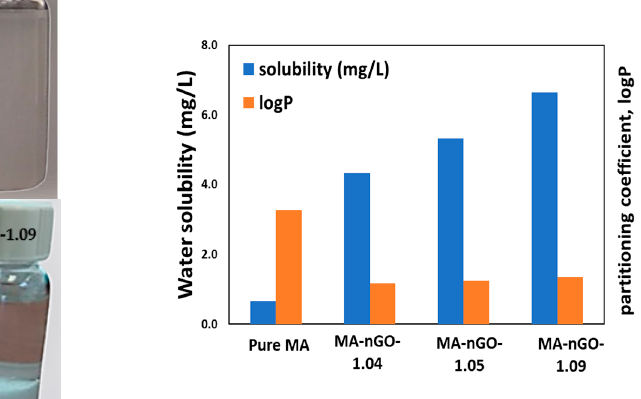
Figure 5. MA-nGO composite particles electrical zeta potential analysis in the Malvern Zetasizer. 2.4. Properties of MA-nGO Composites Figure 6 shows the Raman spectrum of pure MA and MA-nGO composites with various nGO incorporated concentrations. The D-band region at 1340 cm − 1 and G band at 1580 cm − 1 from graphene oxide overlapped with peaks from MA drug. The spectral position of the other peaks in MA did not change. The strong spectral intensity peak for all the drug composites for different frequency regions suggests the prepared composite has unchanged crystalline structure. XRD was also carried out for crystal structure determination. X-ray powder diffraction (Figure 7) confirmed that the crystal structure of